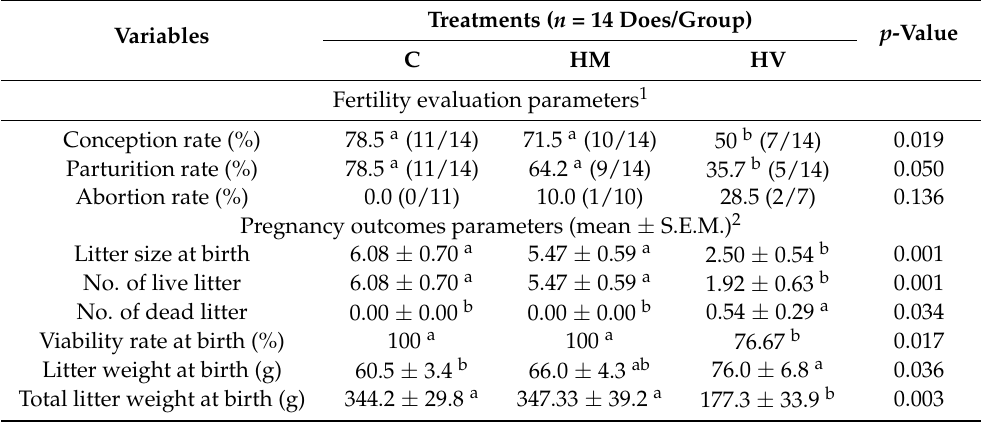
Table 3. Productive traits of rabbit does receiving intramuscular (HM = 0.4 µ g) or intravaginal